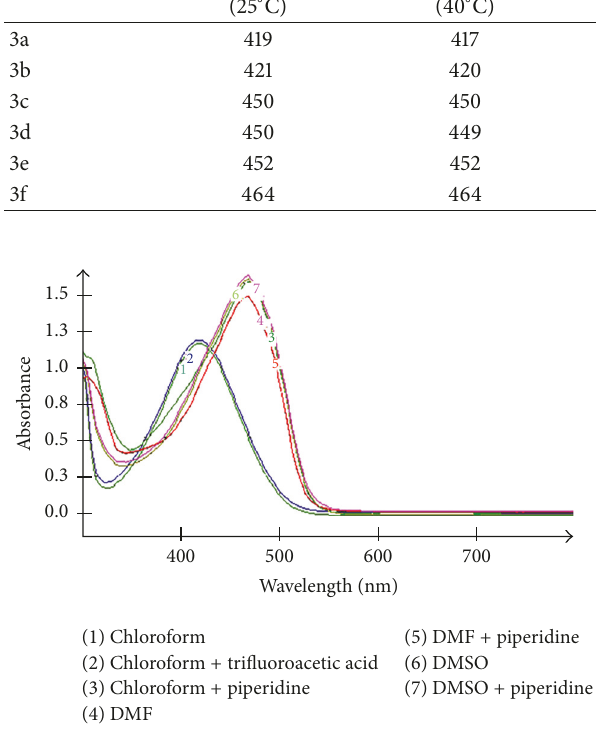
Table 7: The maximum absorption wavelengths (nm) of dyes at different temperature and concentration in chloroform and DMF. Dye number